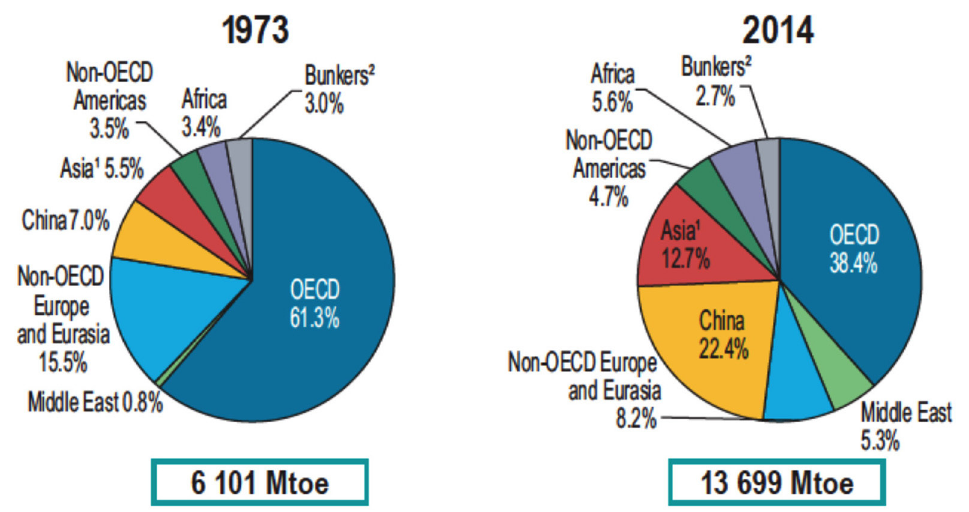
Fig. 4. – 1973 and 2014 regional shares of TPES. 1 Asia excludes China and OECD countries of Asia. 2 Includes international aviation and international marine bunkers. (Courtesy of